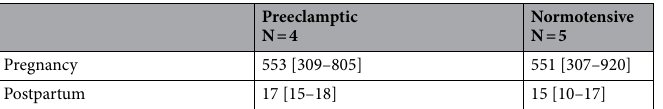
Table 2. Soluble syndecan-1 during normotensive and preeclamptic pregnancy compared to 3 months postpartum. Numbers represent median and [interquartile range] in ng/ml. Postpartum soluble syndecan-1 was determined in 5 previously normotensive pregnant women and 4 previously preeclamptic women.